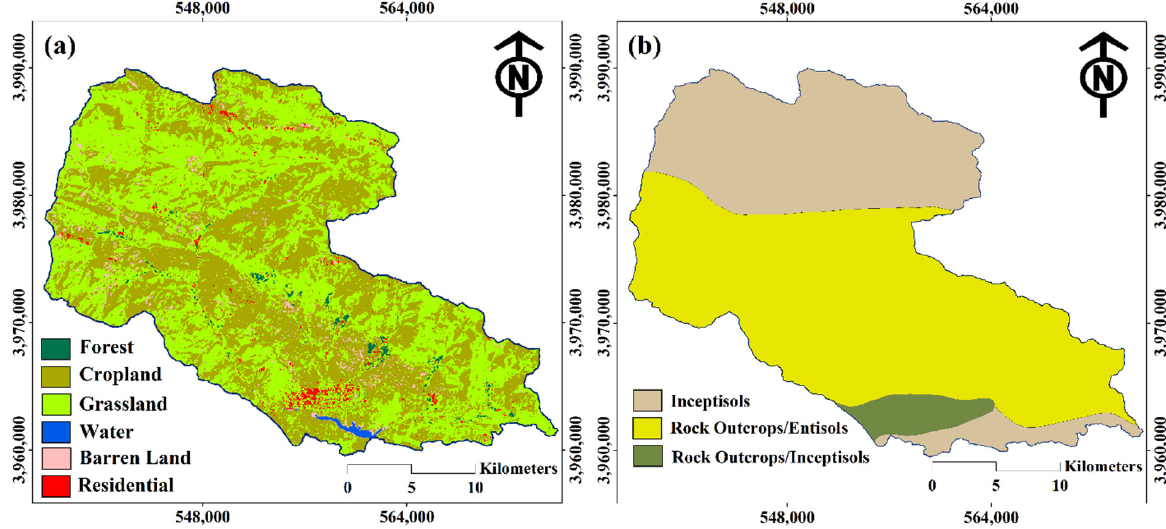
Figure 4. Layers used in SWAT model: ( a ) LULC map; ( b ) Soil map.